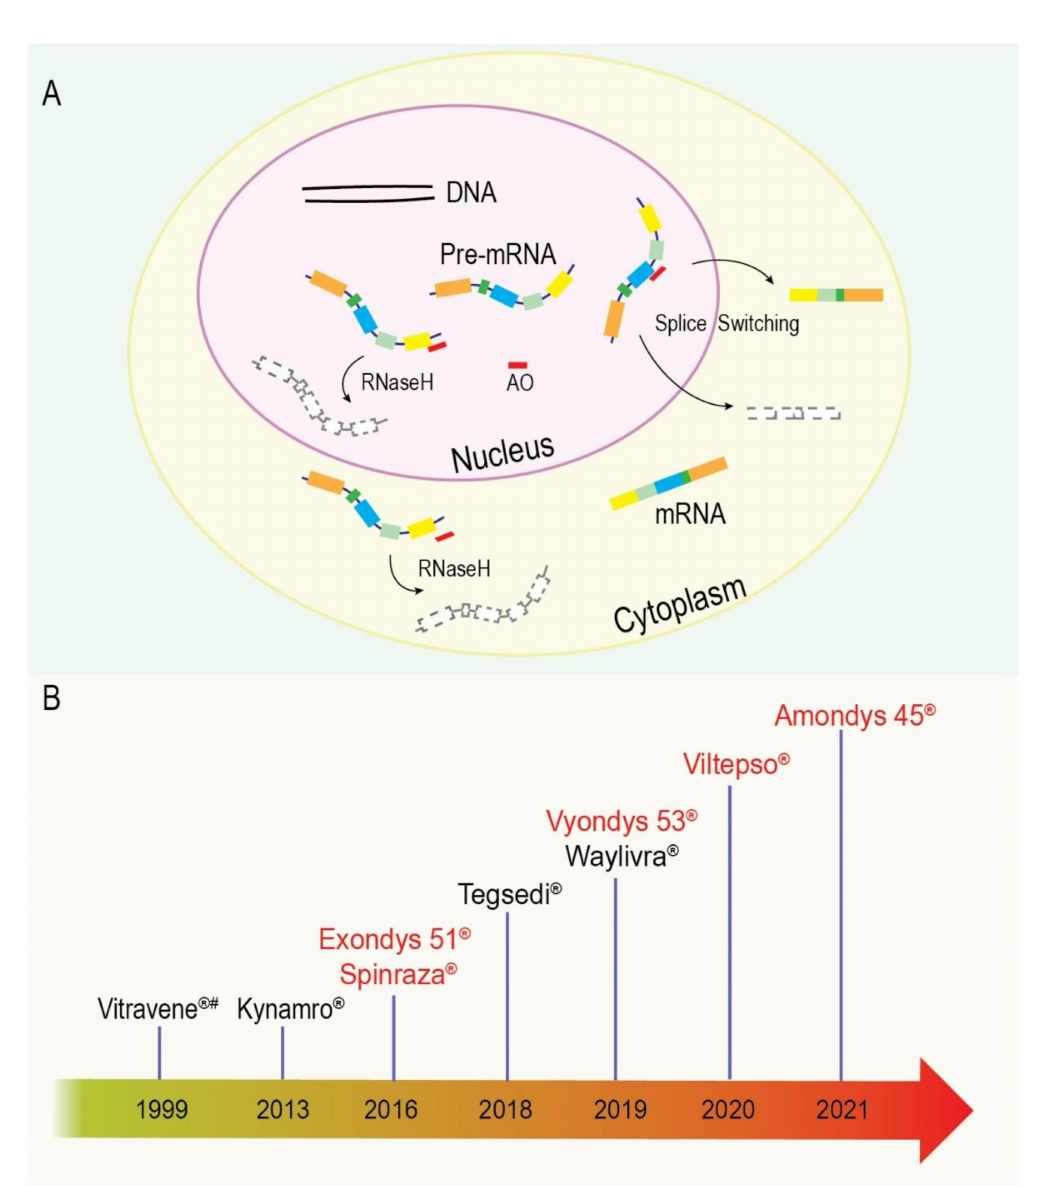
Figure 4. Two common antisense oligonucleotide (AO) mechanisms and the timeline of US Food and Drug Administration approvals for various AOs: ( A ) schematic of the RNaseH and splice-switching AO mechanisms. RNaseH-inducing AO results in mRNA cleavage and downregulation. Splice-switching AO induces exon skipping and/or downregulation of the target through non-sense-mediated decay. AO is depicted in red; ( B ) approved splice-switching AOs are in red, and RNaseH inducing AO are in black. # = currently withdrawn approval. Kynamro has a boxed warning ‘black box warning’. ® = registered